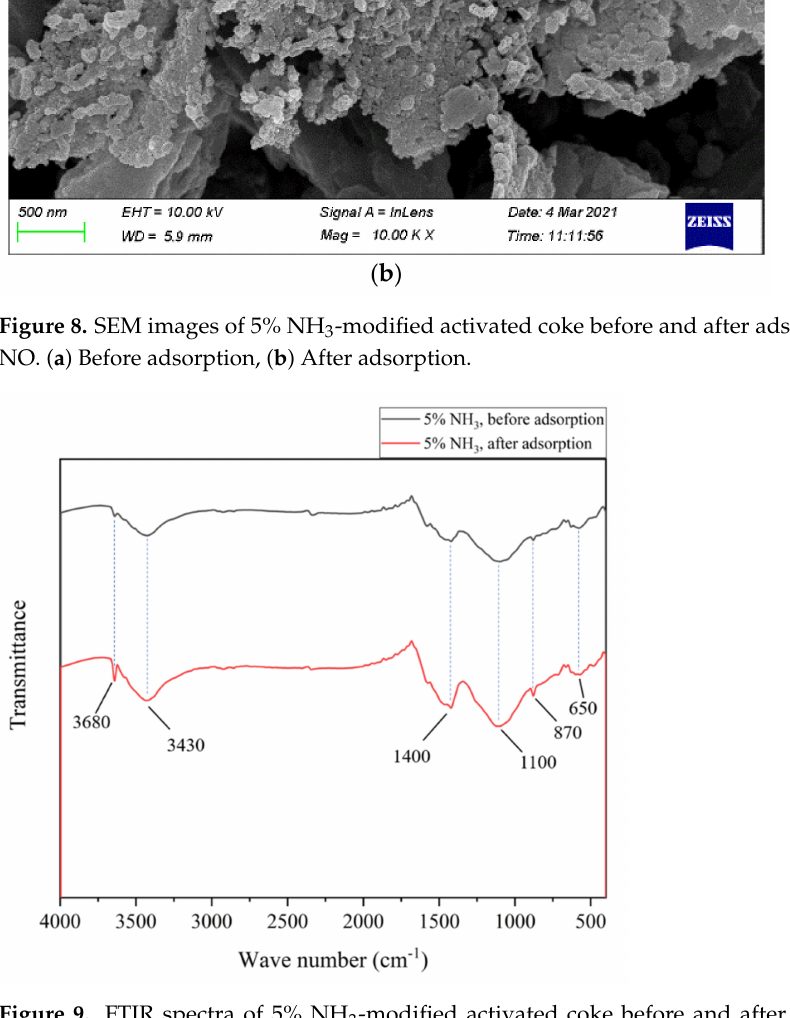
Figure 9. FTIR spectra of 5% NH 3 -modified activated coke before and after adsorption of SO 2 and